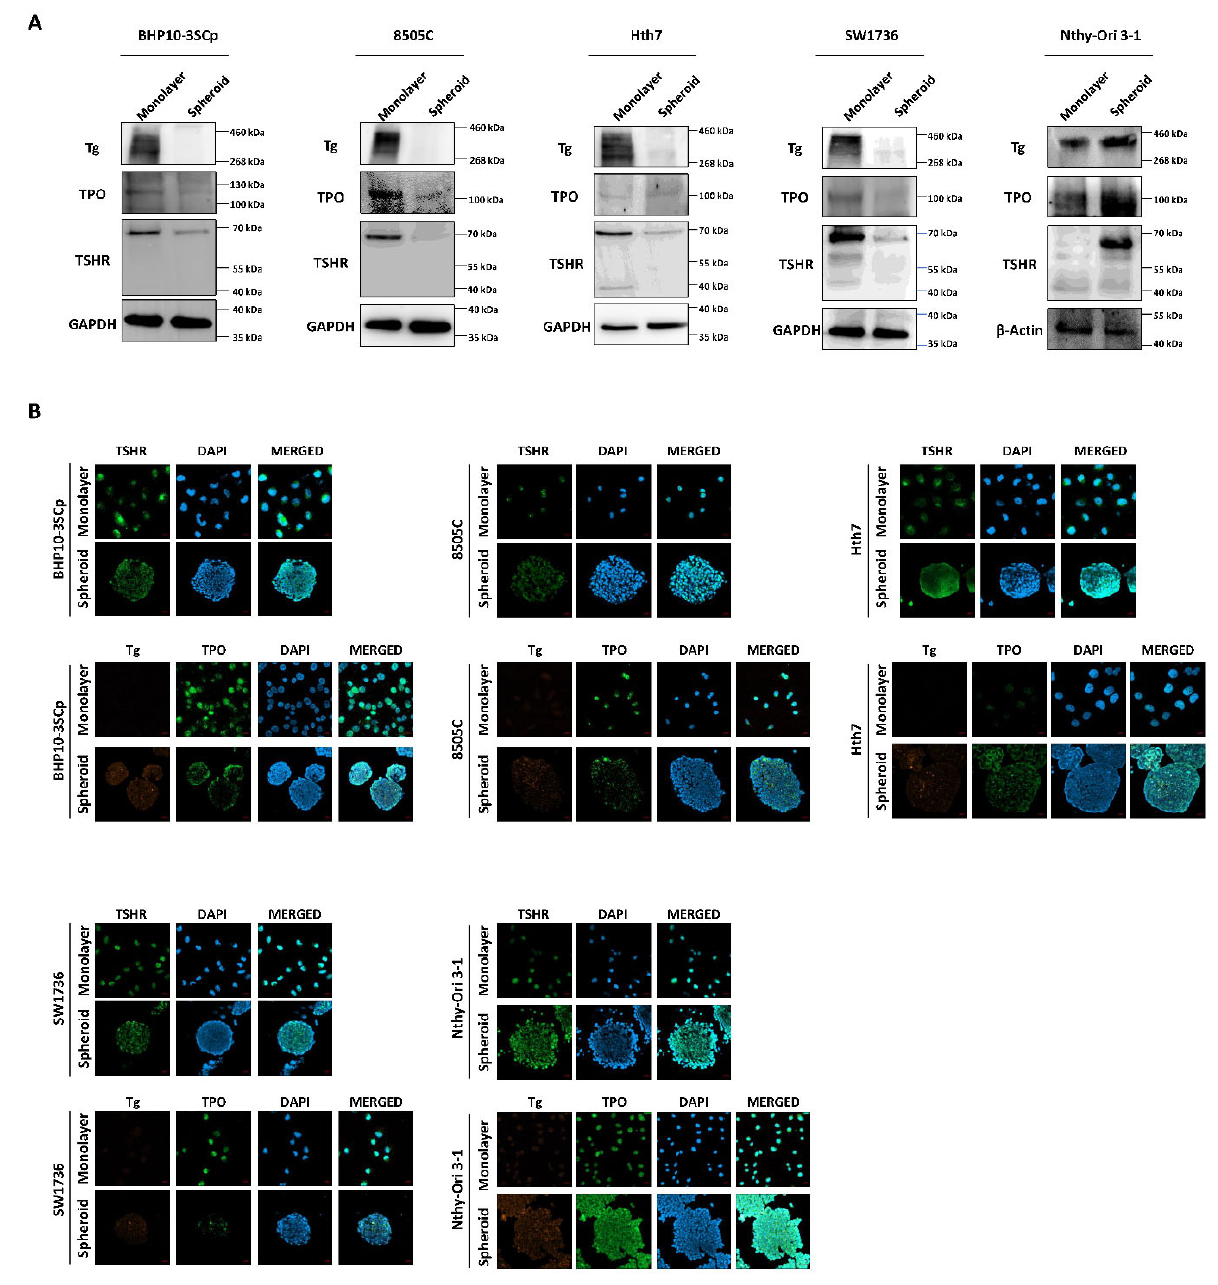
Figure 8. Verification of thyroid-specific proteins expression under 2D monolayer condition and 3D spheroid condition. ( A ) Western blot analysis showing thyroglobulin (Tg), thyroid peroxidase (TPO), and TSH-receptor (TSHR) expression. GAPDH and β -Actin were used as loading control. ( B ) Representative immunofluorescence images showing Tg, TPO, and TSHR. Scale bar: 50 µ m.